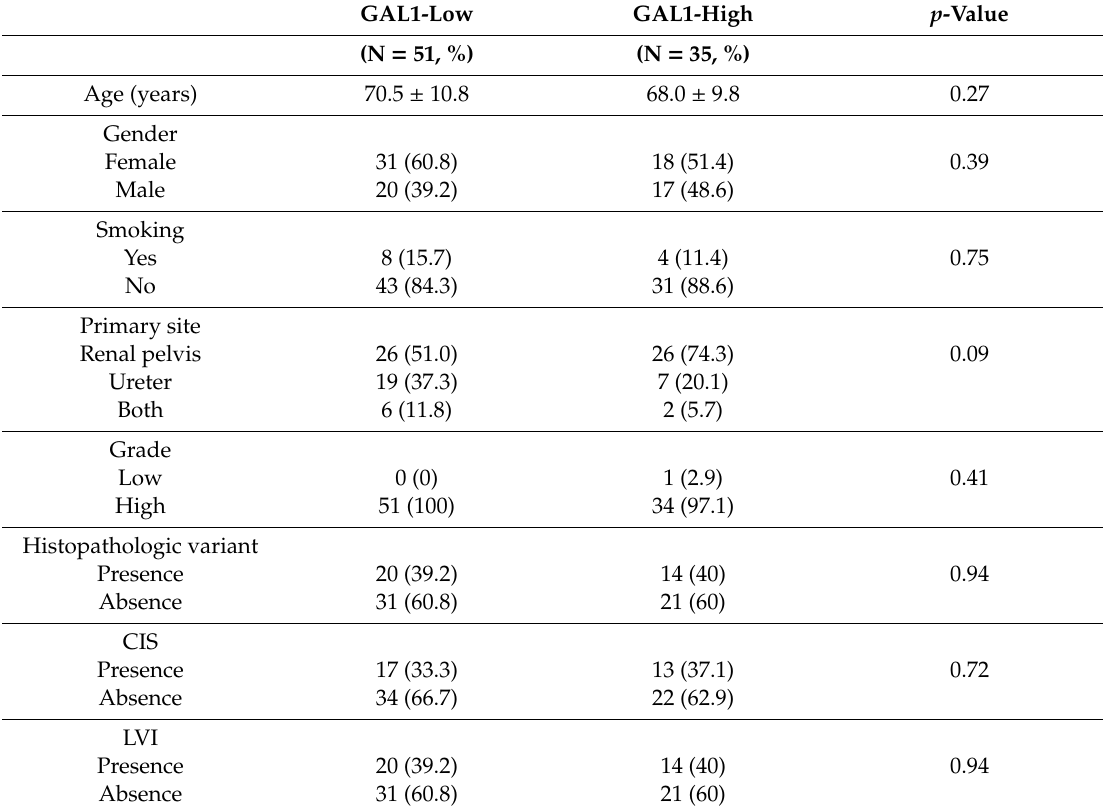
Figure 2. Evaluation of the association between GAL1 expression and oncological outcomes in urothelial carcinoma (UC): High expression of GAL1 reduced overall survival in patients with bladder cancer from the TCGA ( A ) and GSE32894 ( B ) cohorts. Representative immunohistochemical (IHC) images of low GAL1 ( C , D ) and high GAL1 ( E , F ) expression levels. Kaplan–Meier analysis of 86 patients with pT3 upper tract urothelial carcinoma (UTUC) for determining recurrence-free survival (RFS) ( G ) and cancer-specific survival (CSS) ( H ). Table 1. Clinicopathological features of 86 patients with pT3 upper tract UC stratified by GAL1 expression. GAL1-Low